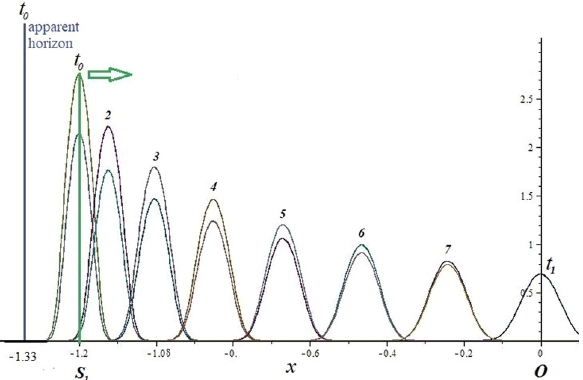
Fig. 2 The consecutive profiles in a logarithmic scale of the intensity anddensity(smaller)ofthefermionemittedbythesource S 1 .Thisstarts with an initial velocity less than one because of the dragging effect, and then it accelerates up to the speed of light measured in O . The decay and dispersion are